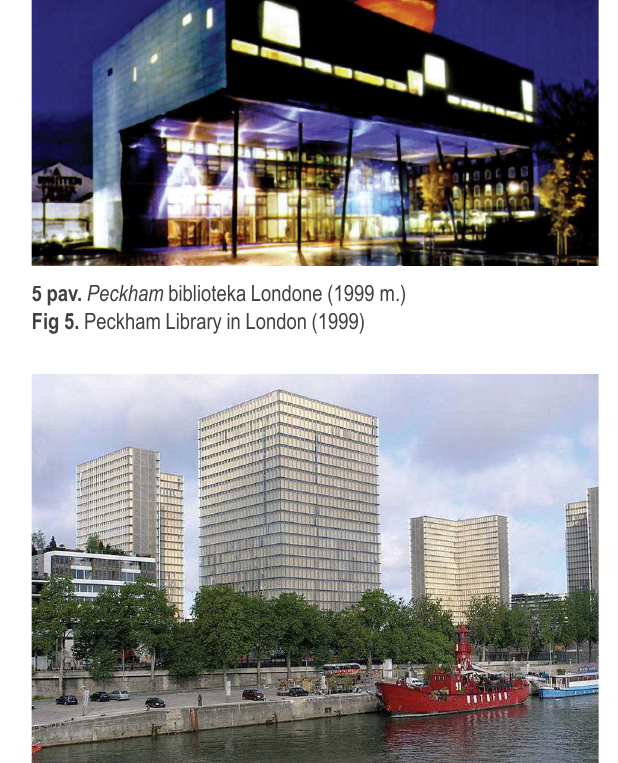
Fig 6. National Library in Paris (1996)